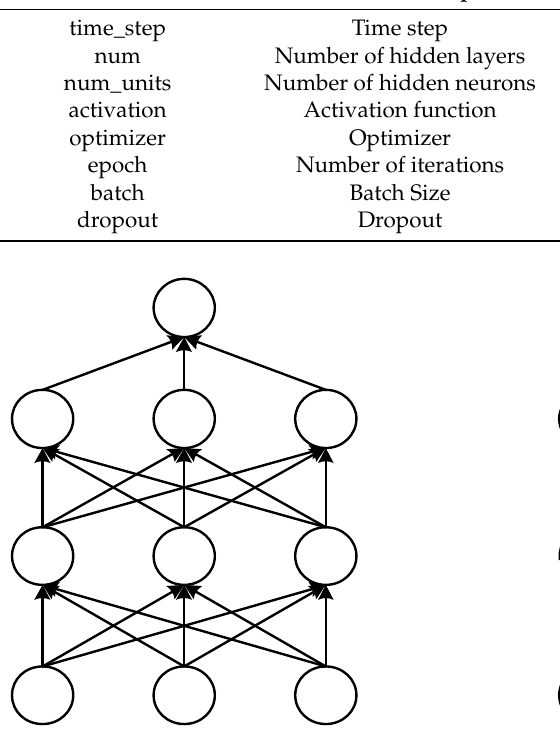
Figure 10. Dropout mechanism diagram.